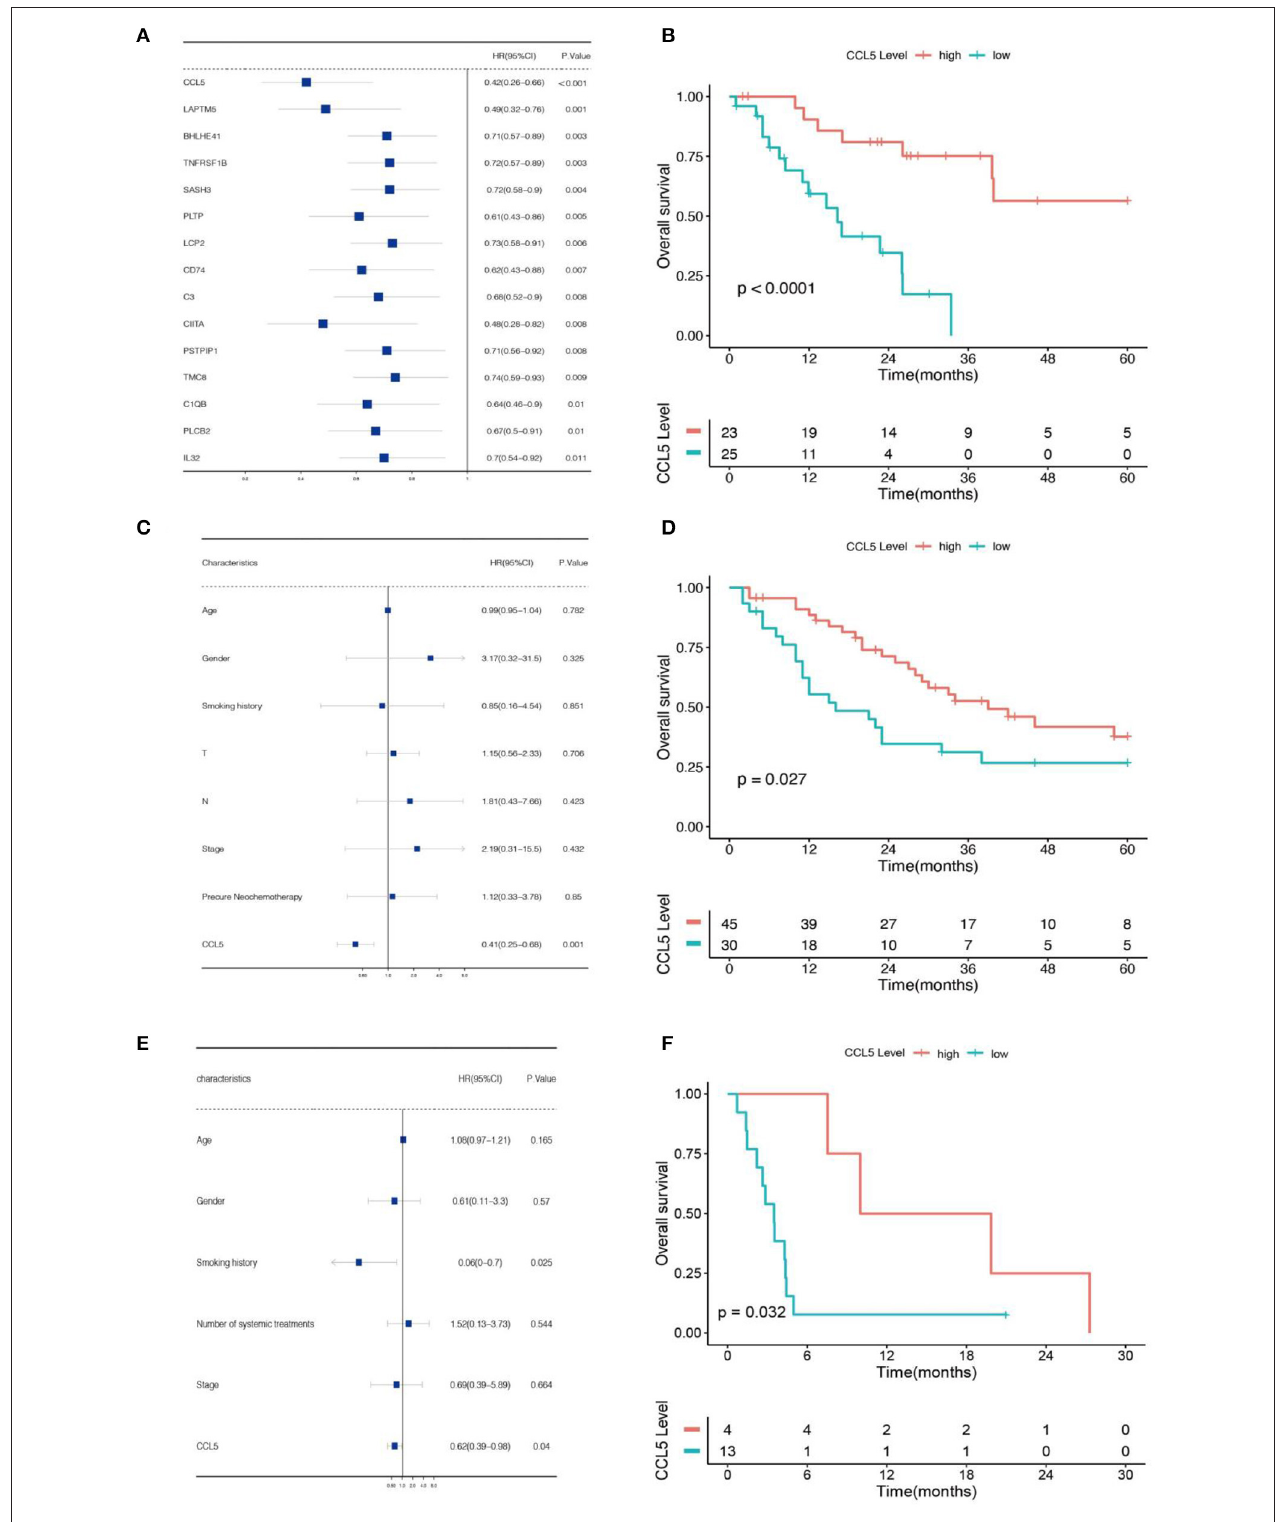
FIGURE 2 | (A) Univariate Cox regression analysis of data from the Jiang cohort. (B) Association between CCL5 and overall survival based on data from Jiang cohort. (C) Multivariate Cox regression analysis of data from the Jiang cohort. (D) Association between CCL5 and overall survival based on data from George cohort. (E) Multivariate Cox regression analysis of data from the Roper cohort. (F) Association between CCL5 and overall survival based on data from Roper cohort.